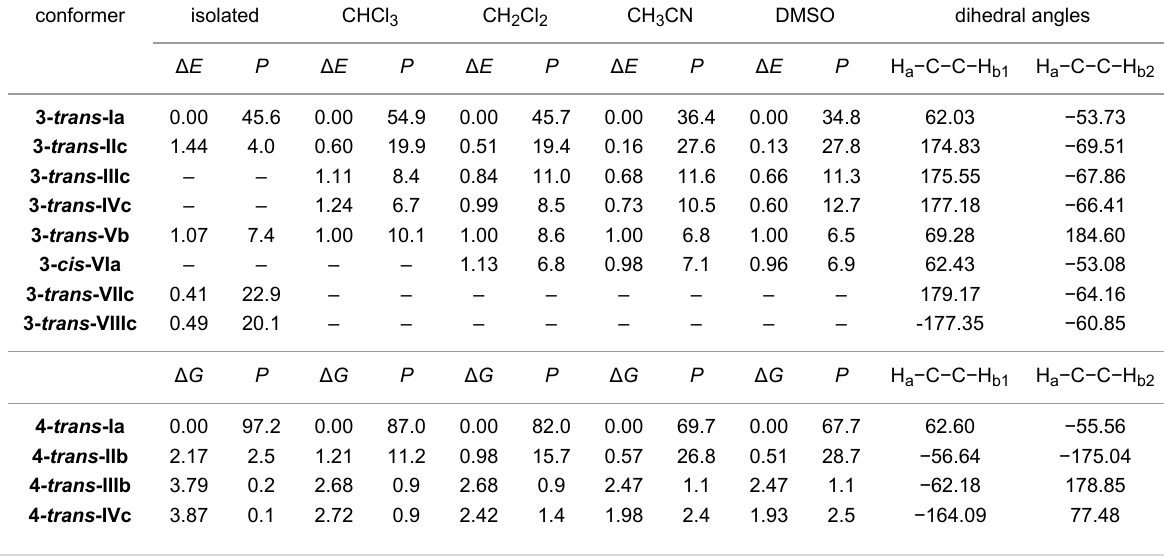
Table 5: Calculated parameters ( ω B97X-D/aug-cc-pVTZ) for conformers of 3 and 4 in isolated phase and in solution (IEF − PCM). Relative Gibbs free energies ( Δ G ) and electronic energies with ZPE corrections ( Δ E ) are given in kcal mol − 1 , populations ( P ) in %, and dihedral angles in degrees.